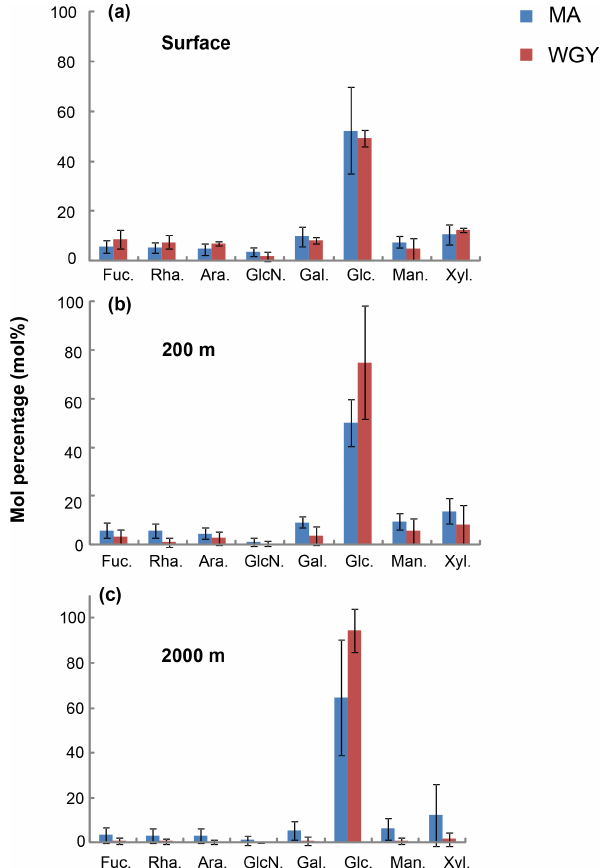
Figure 5. Average mole percentage (mol%) of dissolved monosac- charides at (a) the surface, (b) 200m and (c) 2000m of depth for MA and WGY areas. Monosaccharide abbreviations are as fol- lows. Fuc.: fucose; Rha.: rhamnose; Ara.: arabinose; GlcN.: glu- cosamine; Gal.: galactose; Glc.: glucose; Man.: mannose and Xyl.: xylose.